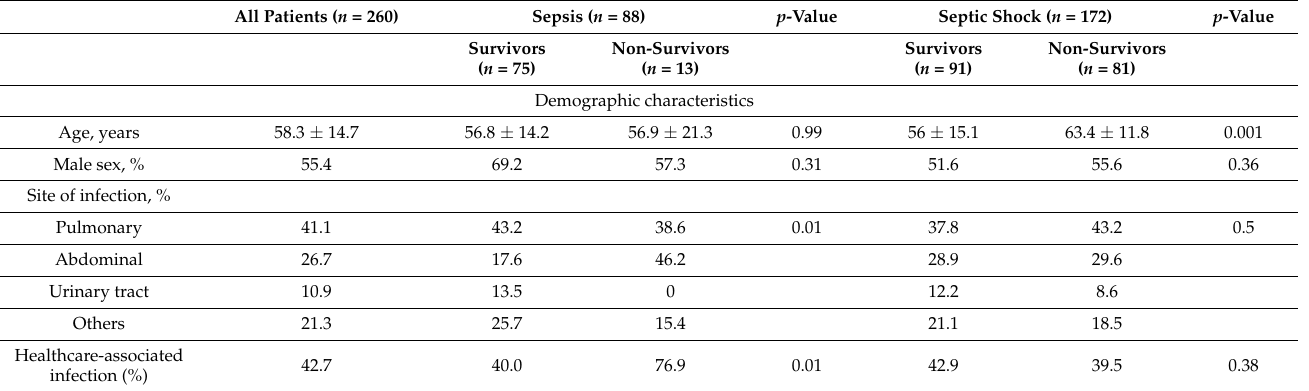
Table 1. Baseline characteristics and blood concentration of biomarkers in all patients and a compari- son by the diagnosis at admission to the ICU and